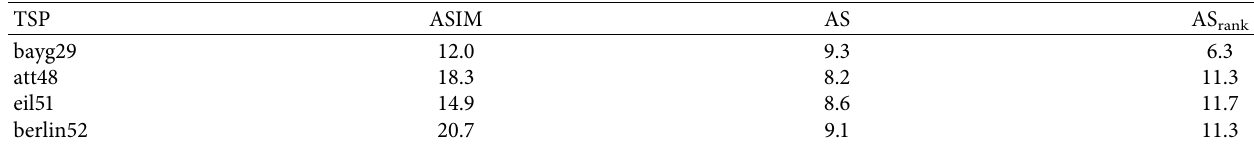
Table 3: Average number of update times of the best solution in 20